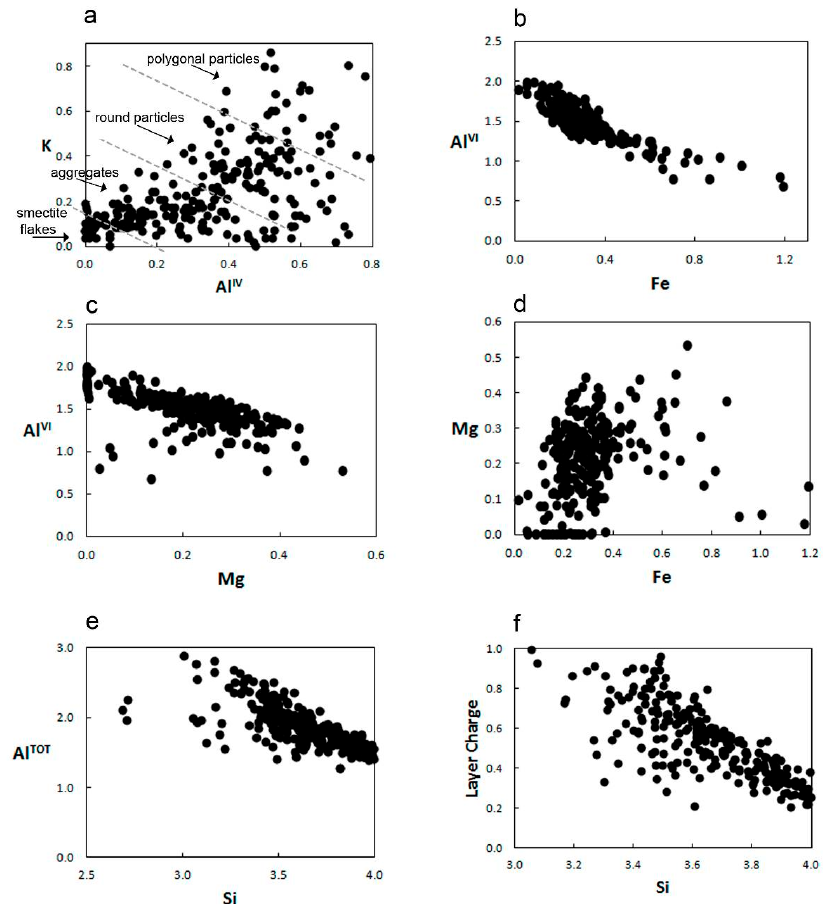
Figure 4. Compositional variation of the smectites and I-S phases normalizing to 10 O atoms and 2 (OH) groups per structural formula. ( a ) K content vs. tetrahedral Al (Al IV ); ( b ) Tetrahedral Aluminum (Al IV ) vs. Fe content; ( c ) Tetrahedral Aluminum (Al IV ) vs. Mg content; ( d ). Mg vs. Fe content; ( e ) Total Al (Al TOT ) vs. Si content; ( f ) Layer charge vs Si